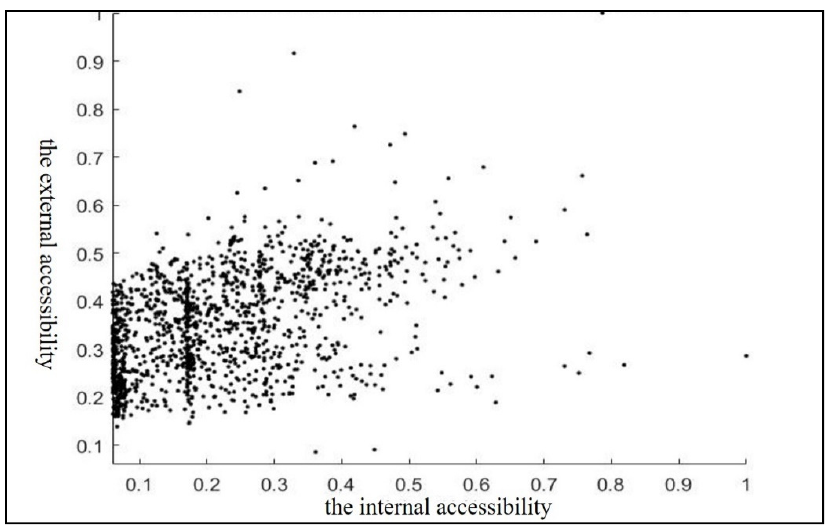
Figure 10. Diagram of correlation between the external accessibility and the internal accessibility of the grids of Zhicheng.